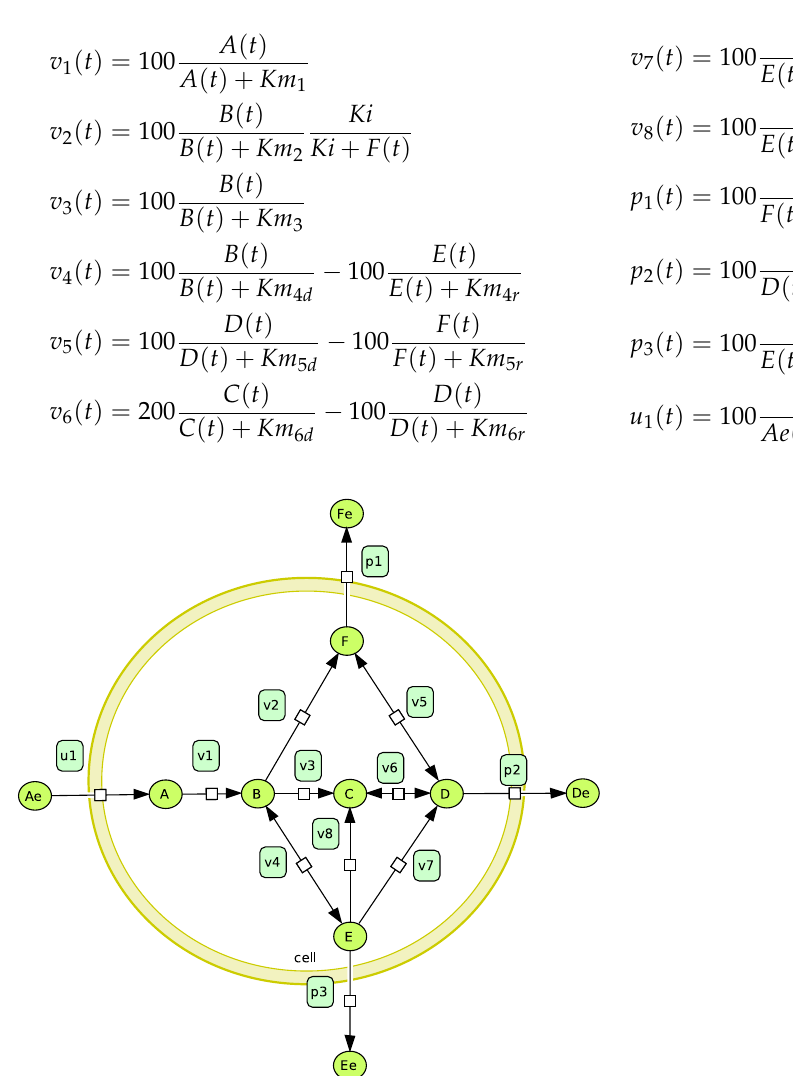
Figure 2. Example of a production system. Inspired by